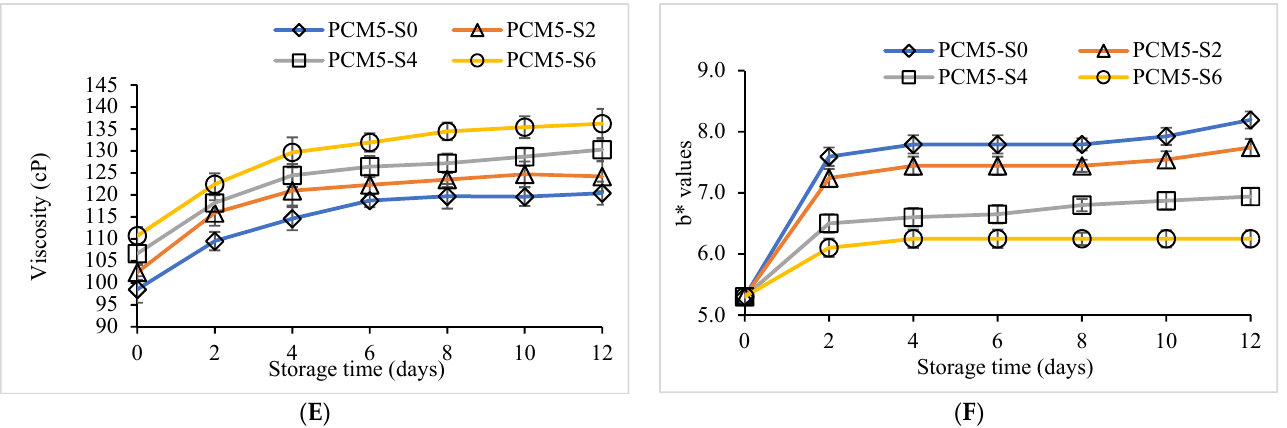
Figure 2. pH ( A ), Total soluble solid ( B ), viscosity ( C ), L* values ( D ), a* values ( E ), and b* values ( F ) of PCM extracted from 5 min steamed purple corn kernels without and with sucrose addition during 12 days of storage at 4 °C. Values are presented as mean ± standard deviation ( n = 3). PCM: Purple corn milk; PCM5-S0: PCM extracted from 5 min steamed kernels without sucrose addition and pasteurization; PCM5-S2, PCM5-S4, PCM-S6: samples extracted from 5 min steamed kernels fortified with 0 to 6% sucrose followed by pasteurization.